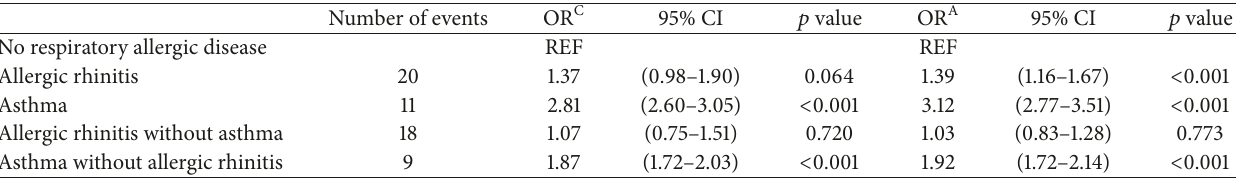
Table 3: Stratified PS matched conditional logistic regression of prevalence of